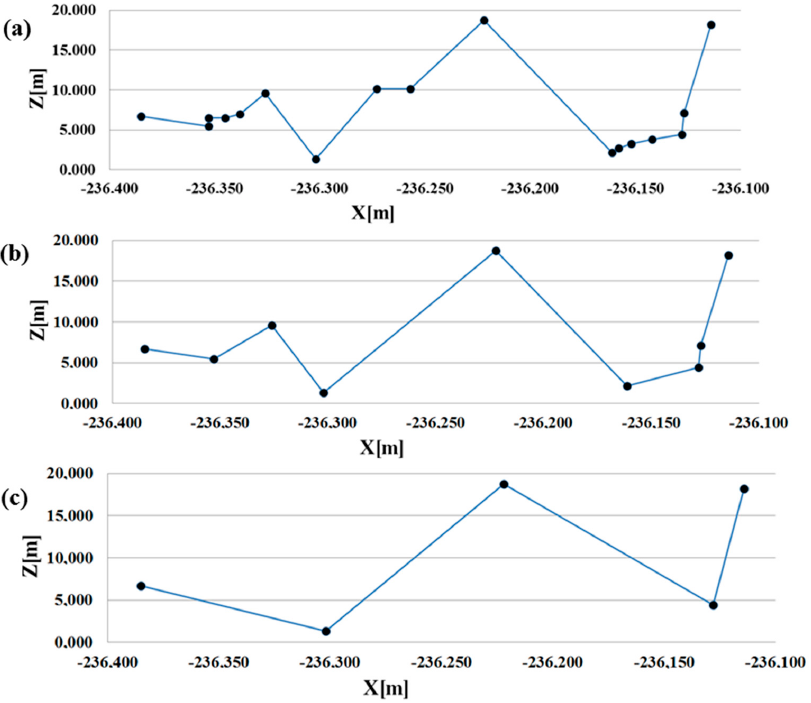
Figure 3. D-P method on a measurement strip, ( a ) original; ( b ) after reduction with tolerance t 1 ; ( c ) after reduction with tolerance t 2 .